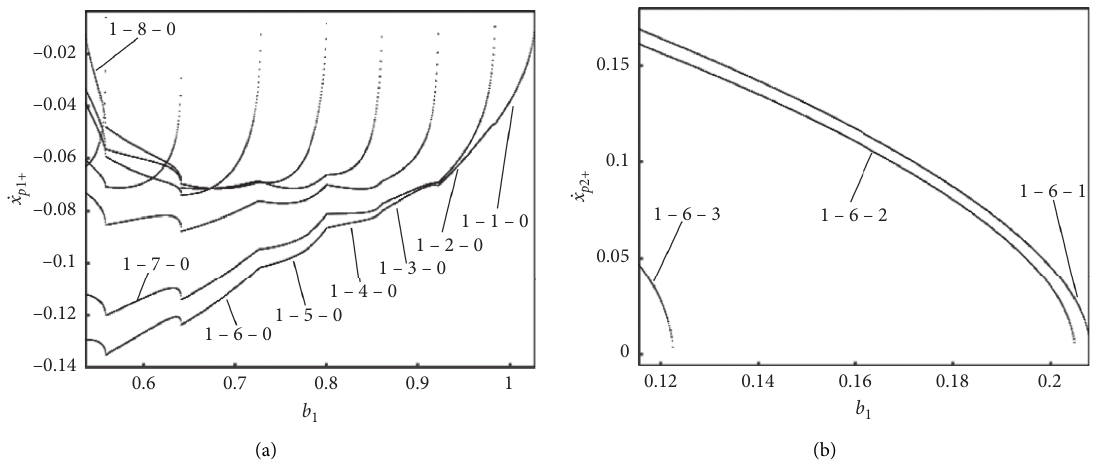
Figure 4: Single-parameter bifurcation diagram of the system. (a) ω � 0 . 1722. (b) ω � 0 . 2822.